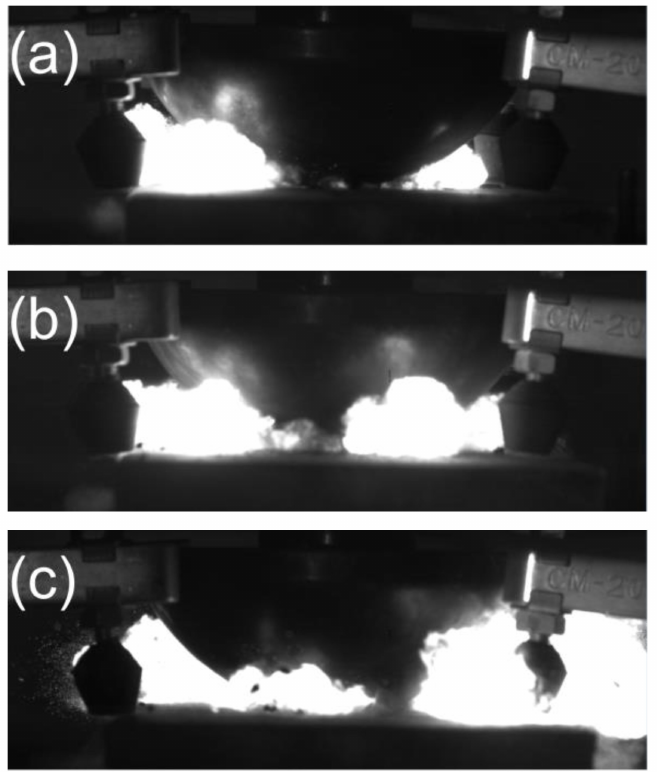
Figure 8. The most intense moments of reactions for different samples. ( a ) No.5# sample; ( b ) No.6# sample; ( c ) No.7# sample.